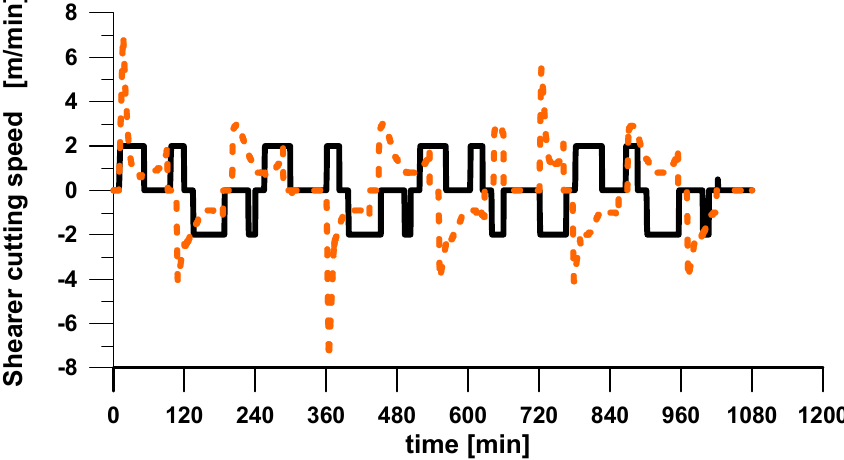
Figure 5. Shearer cutting speed in longwall 841A, where the intermittent orange line represents the controlled speed and the black line indicates a case without speed control.